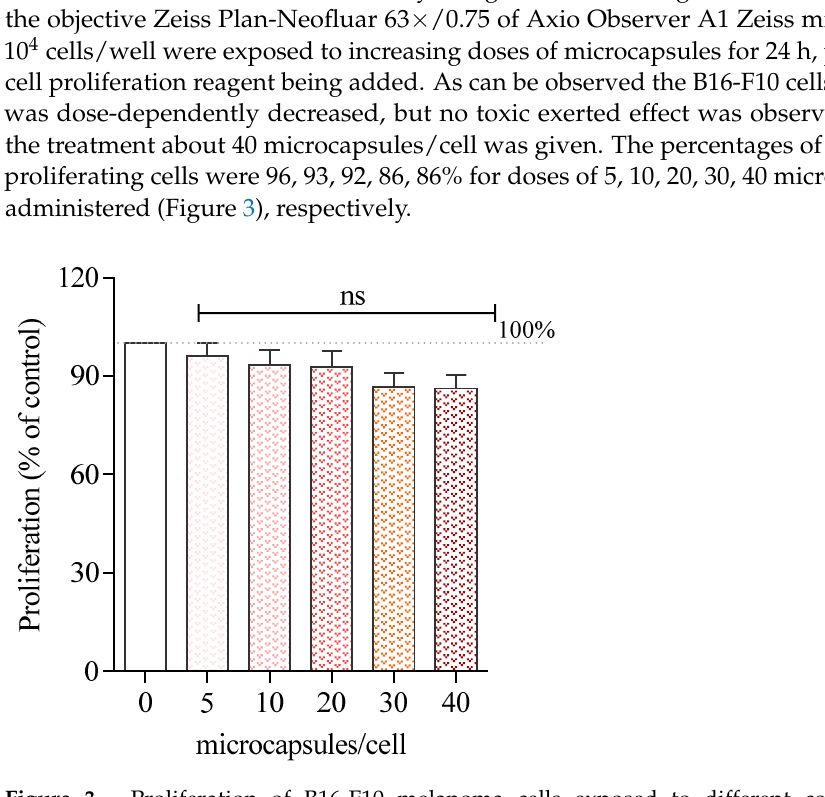
Figure 3. Proliferation of B16-F10 melanoma cells exposed to different concentrations of CaCO 3 (PAH)@RBITC@AN for 24 h. Cell proliferation was assessed by WST-1 assay. Data are expressed as mean ± SEM ( n = 5). Statistically non-significant differences compared with the untreated control. (one-way Anova; post hoc: Dunnett’s multiple comparison test).